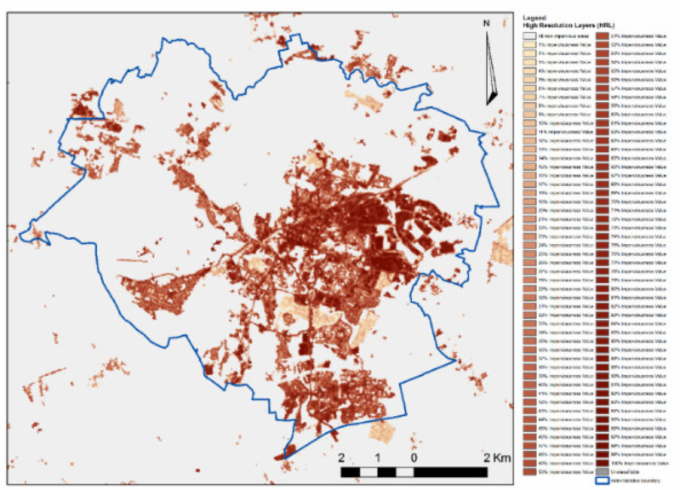
Figure 10. Land cover model in the area under investigation based on HRL Imperviousness data Source: